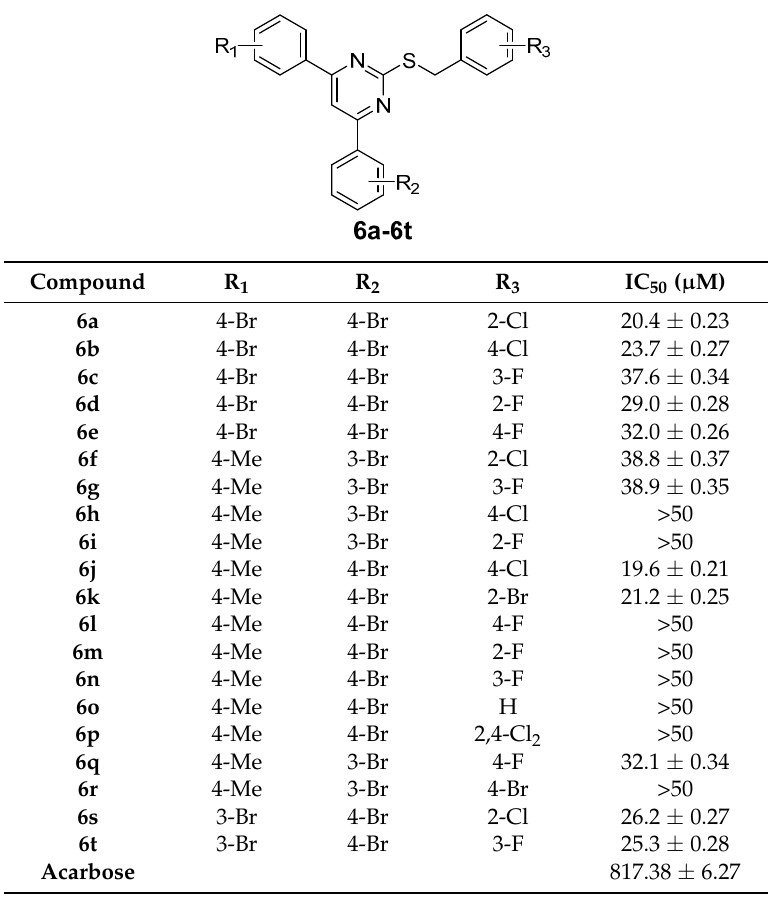
Table 1. α -Glucosidase inhibitory activity of 2-substituted-4,6-diarylpyrimidines 6a – 6t .